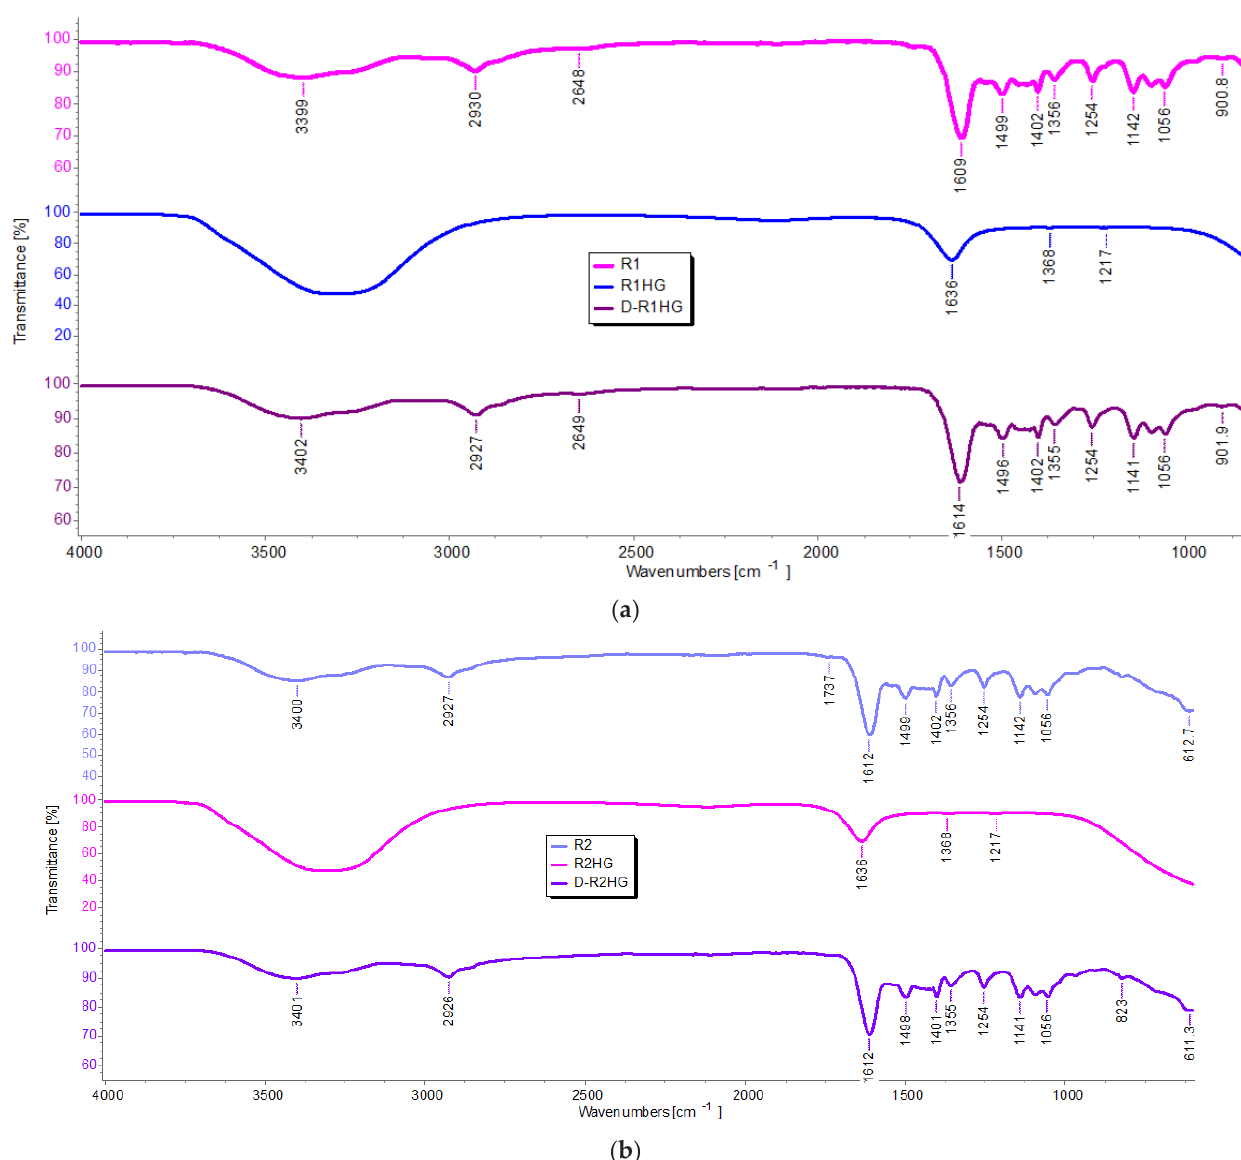
Figure 4. ATR-FTIR spectra of R1, R1HG and D-R1HG ( a ) and of R2, R2HG and D-R2HG ( b ). As expected, the ATR-FTIR spectra of R1 and R2 were very similar and showed the weak CH stretching band of methylene groups (2930 and 2927 cm − 1 respectively) and the weak and large NH stretching band (3399 and 3400 cm − 1 respectively) due to the M1 and M2 contribute. Additionally, strong bands at 1609 and 1612 cm − 1 , typical of di- methyl-acrylamide derivatives, such as DMAA and AAEA, were detected, thus assessing the presence of all three main ingredients in the structure of R1 and R2. No band was observable in the range of 900–911 cm − 1 , (H 2 C=CH- vinyl group), thus confirming the absence of residual monomers. The ATR-FTIR spectra of the soaked R1HG and R2HG were very simple, showing only the typical bands of water, including large OH stretching bands over 3000 cm − 1 and OH scissoring bands at 1636 cm − 1 , thus confirming the very high content of water (>92%) in both R1HG and R2HG. On the contrary, the spectra of the dried samples obtained by heating the soaked gels were very similar to those of R1 and R2, thus establishing that the interactions that occurred during the formation of the gels did not affect the main functional groups of original resins and were reversible. In particular, weak bands at 1496–1498, 1401–1402, 1254, and 1141 cm − 1 provided by the aromatic C=C